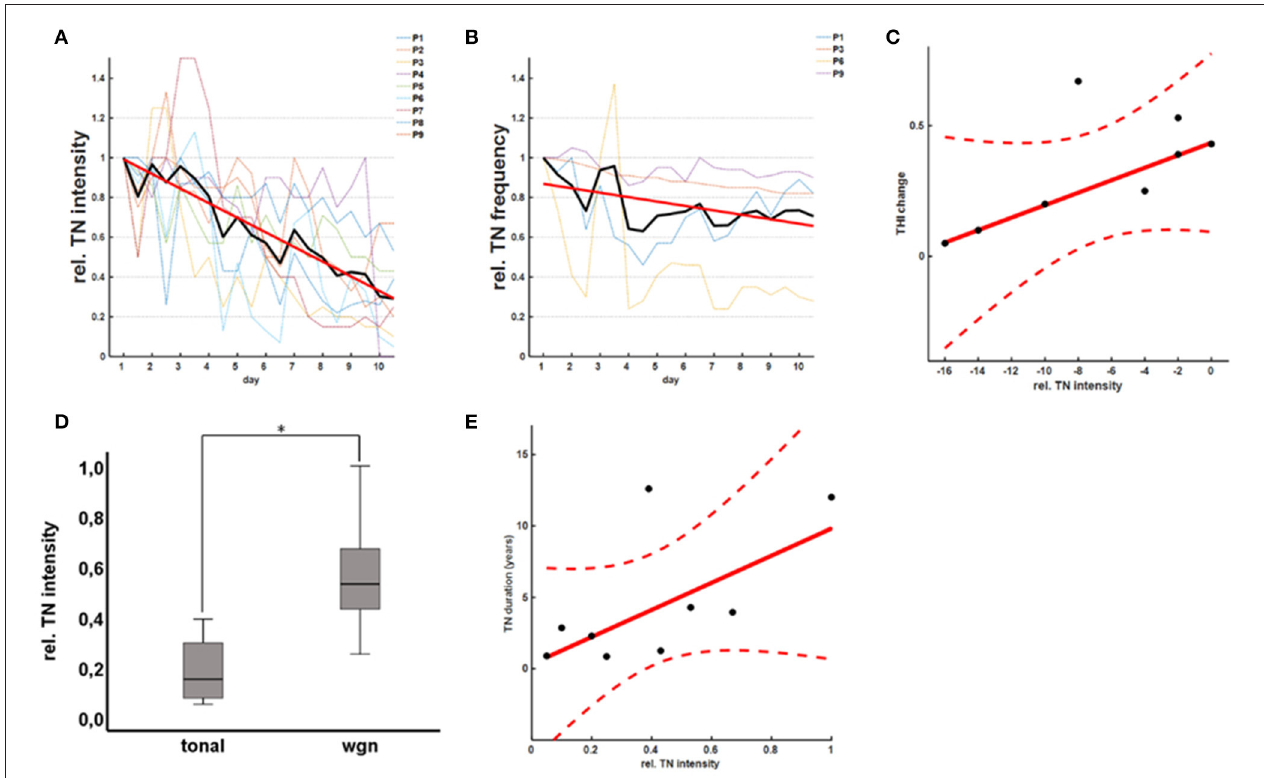
FIGURE 3 | rTMS effects on TN matching. rTMS therapy led to a significant reduction of the TN intensity as measured by the TN matching (A) . In patients with a tonal TN, there was an additional tendency for a reduction of the TN frequency (B) . Notably, there was a good correlation between the acute effect as measured by the THI and the TN matching test (C) . In general, patients with a tonal TN (D) and shorter TN duration (E) showed a better response to rTMS